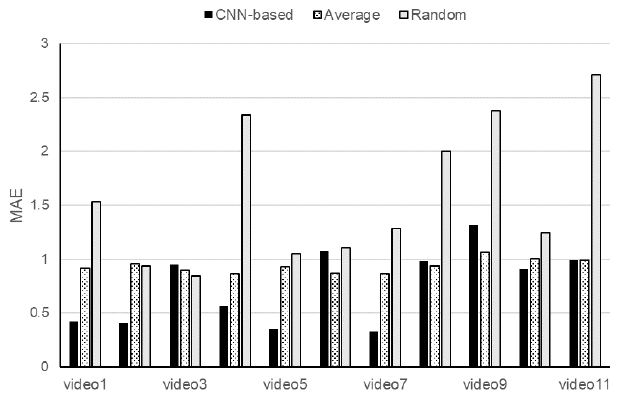
Figure 8. Comparison of rating prediction models for new users.